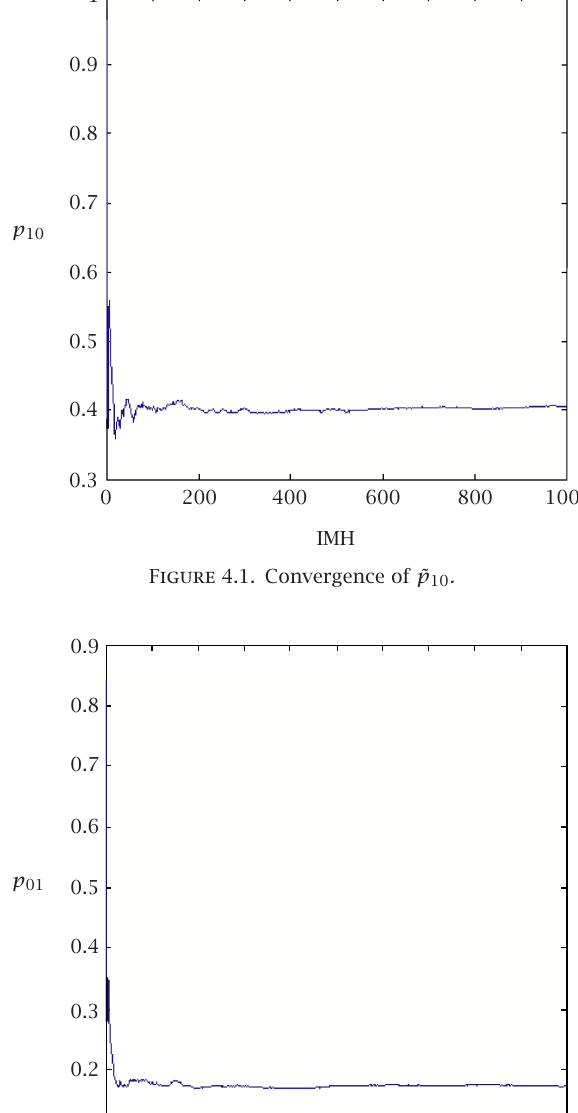
Figure 4.2 . Convergence of ˜ p